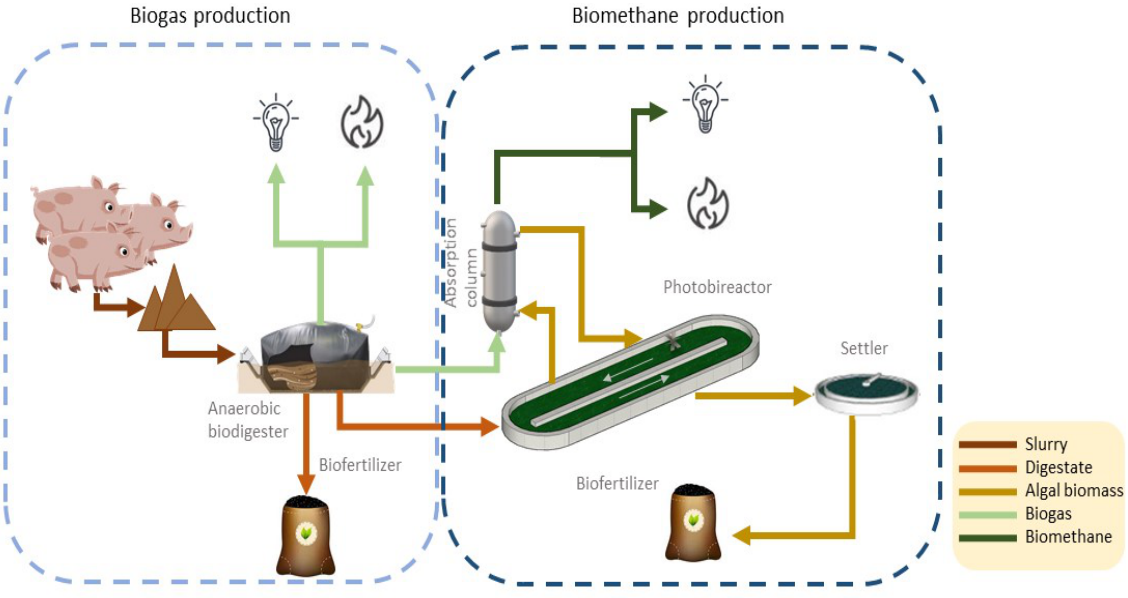
Figure 4. Production systems. Authors’ own elaboration.